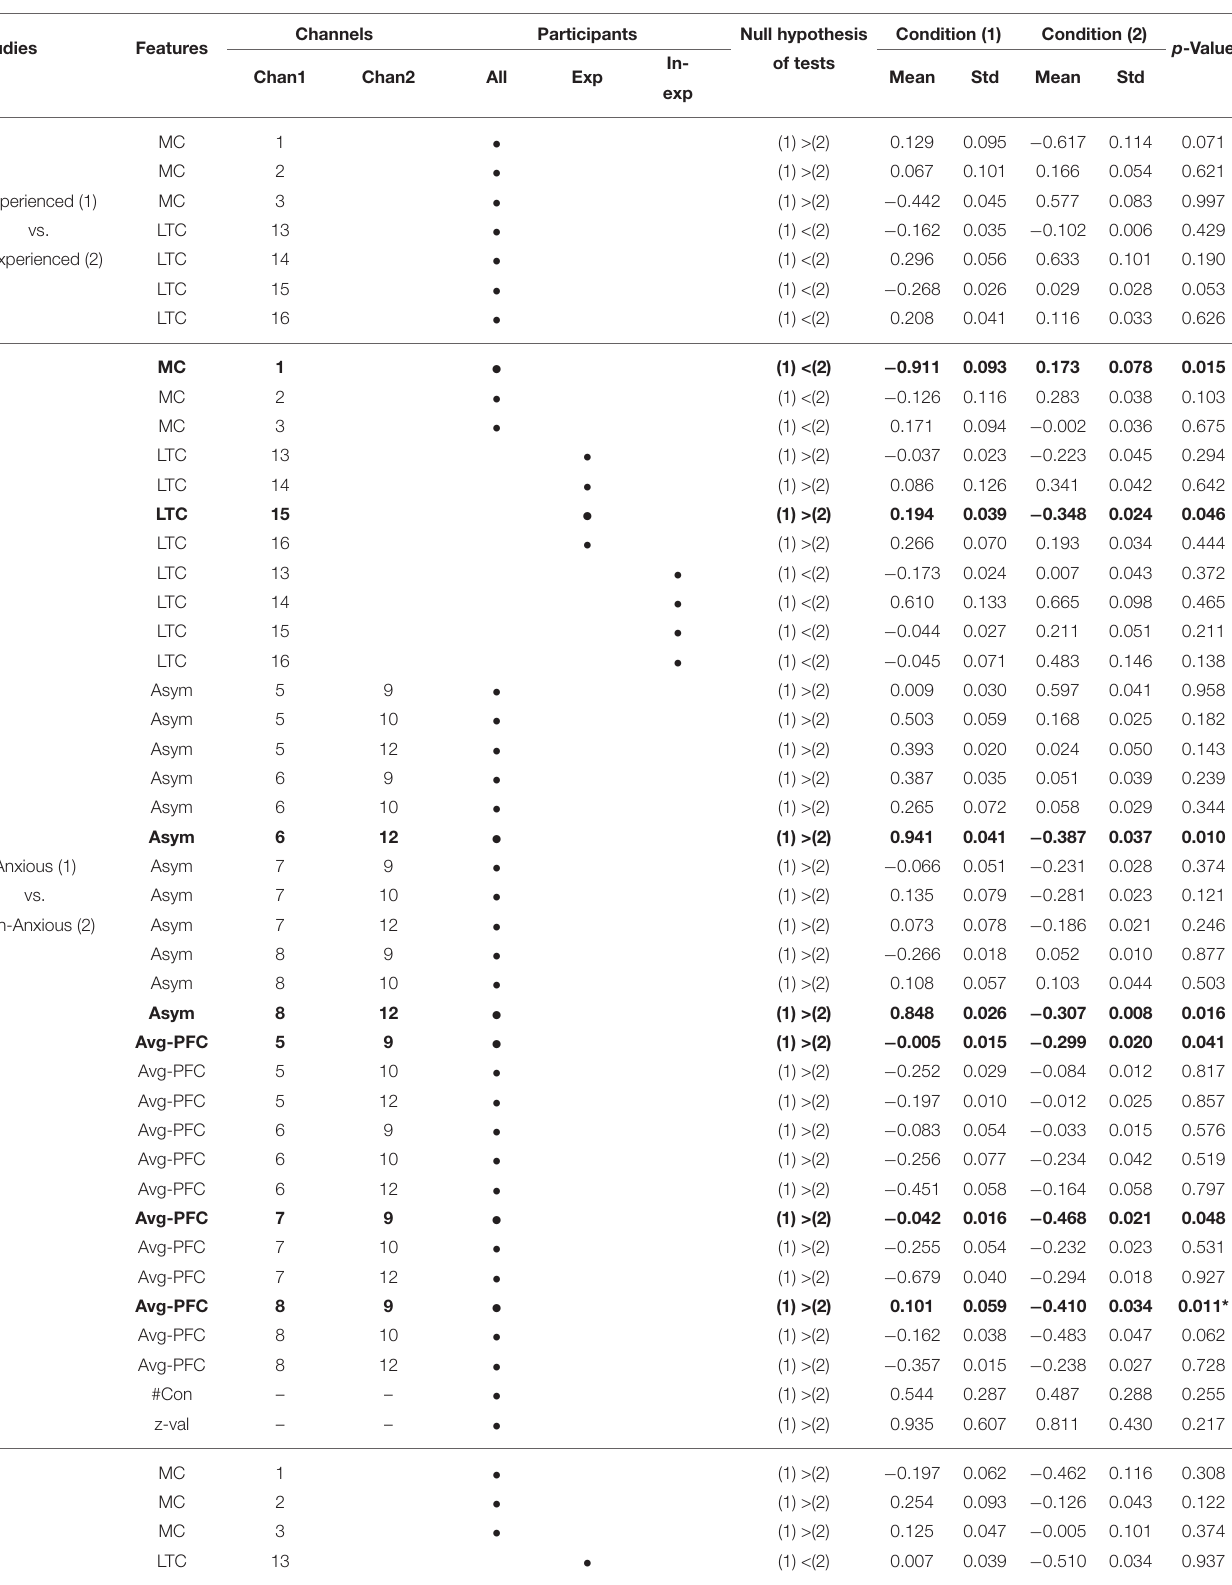
TABLE 2 | Statistics [mean and standard deviation (Std)] and results from the statistical test ( p -values) comparing features from two conditions in a specific study regarding experience, anxiety, and success/failure.